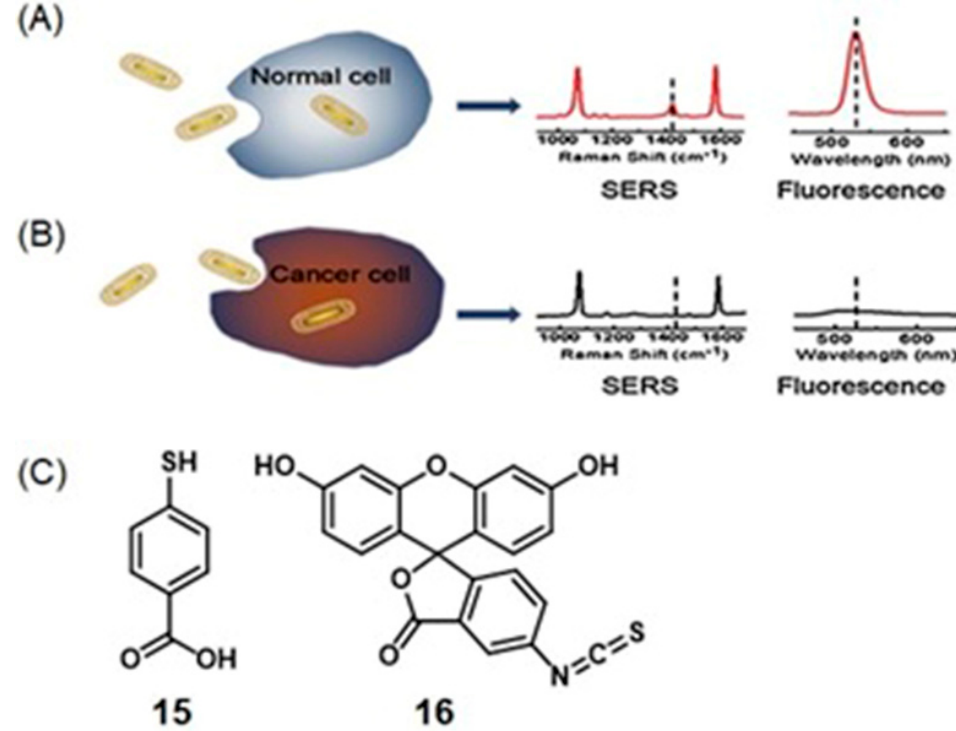
Figure 37. The sensing mechanism of functionalized gold nanoprobe in cells. ( A ) Under normoxic conditions. Internalized probe results in a carbon stretching band in the SERS spectrum at 1423 cm − 1 and a strong absorption peak in fluorescence spectrum. ( B ) Upon entering into hypoxic cells, both signals disappear. ( C ) Chemical structures of 15 and 16 . Adapted from Colloids and Surfaces A: Physicochemical and Engineering Aspects , 562 , Yang, G.; Zhang, Q.; Liang, Y.; Liu, H.; Qu, L.-L.; Li, H. Fluorescence-SERS dual-signal probes for pH sensing in live cells, 289–295, Copyright 2019, with permission from Elsevier [341].